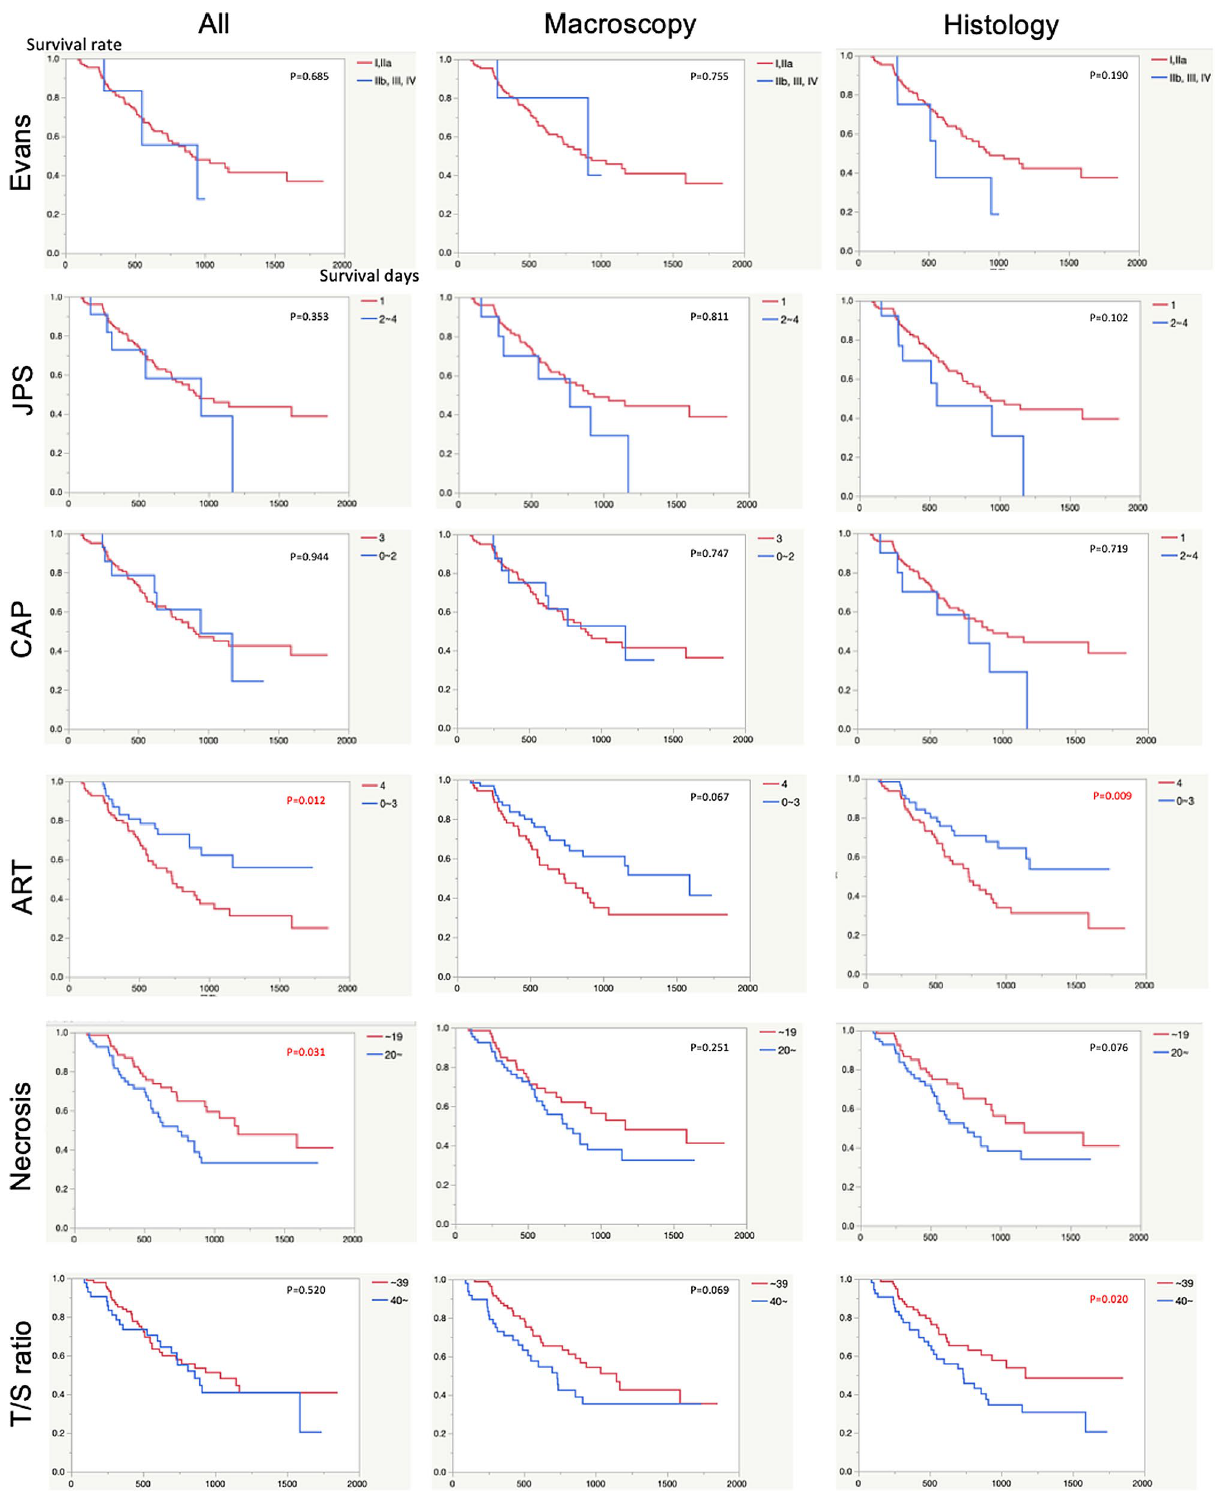
Figure 2. Overall survival of patients receiving neoadjuvant therapy. Kaplan–Meier analysis was performed to analyze the relationship between overall survival and clinicopathological features. All evaluation using all slides of the pancreas; Macroscopy, evaluation using the largest cancer cut surface determined macroscopically; Histology, evaluation using the largest cancer slide determined